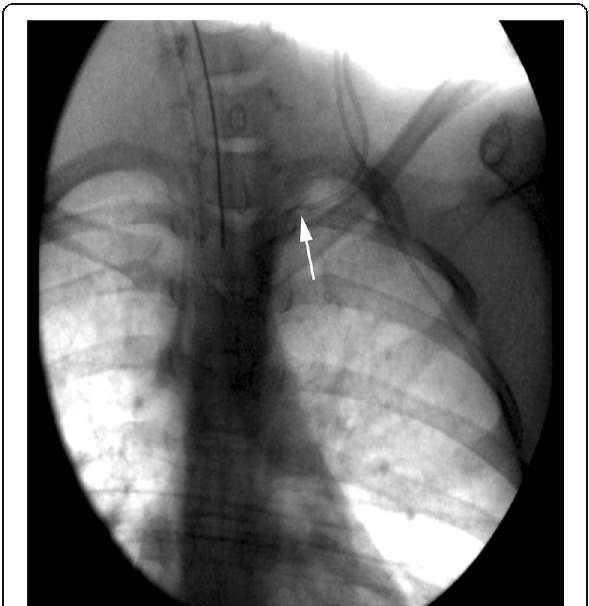
Fig. 1 Patient 1 intra-operative fluoroscopic picture. CVC inserted into the anterior branch of the EJV which followed the same course of the main EJV (before branching) but failed to be threaded into the right atrium. The white arrow is pointing to the tip of the central venous line